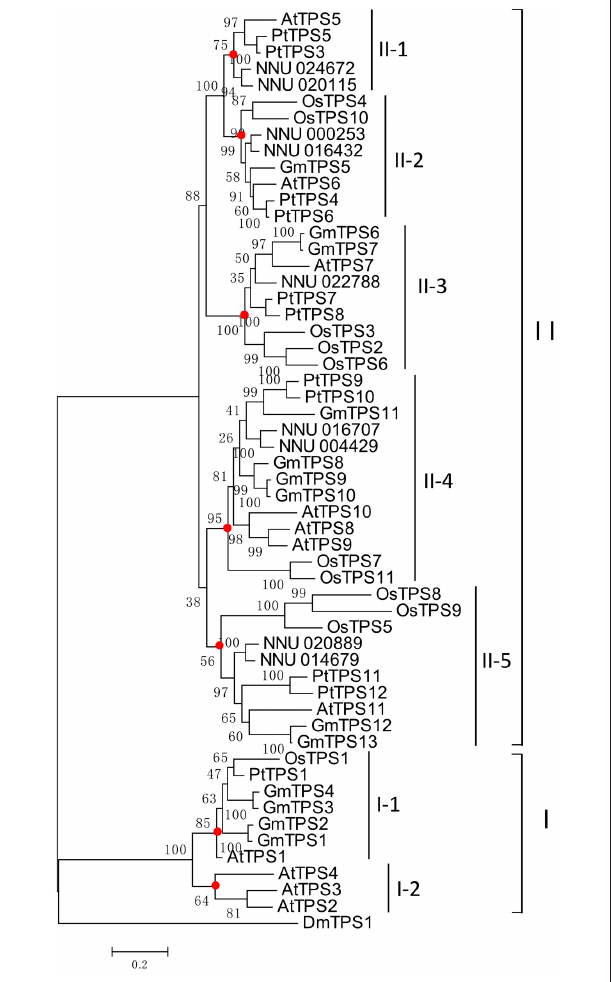
FIGURE 5 | Phylogenetic relationships of the TPS from lotus, Arabidopsis (AtTPS), poplar (PtTPS), soybean (GmTPS), and rice (OsTPS). Red circles indicate the most recent common ancestral TPS genes among dicots and